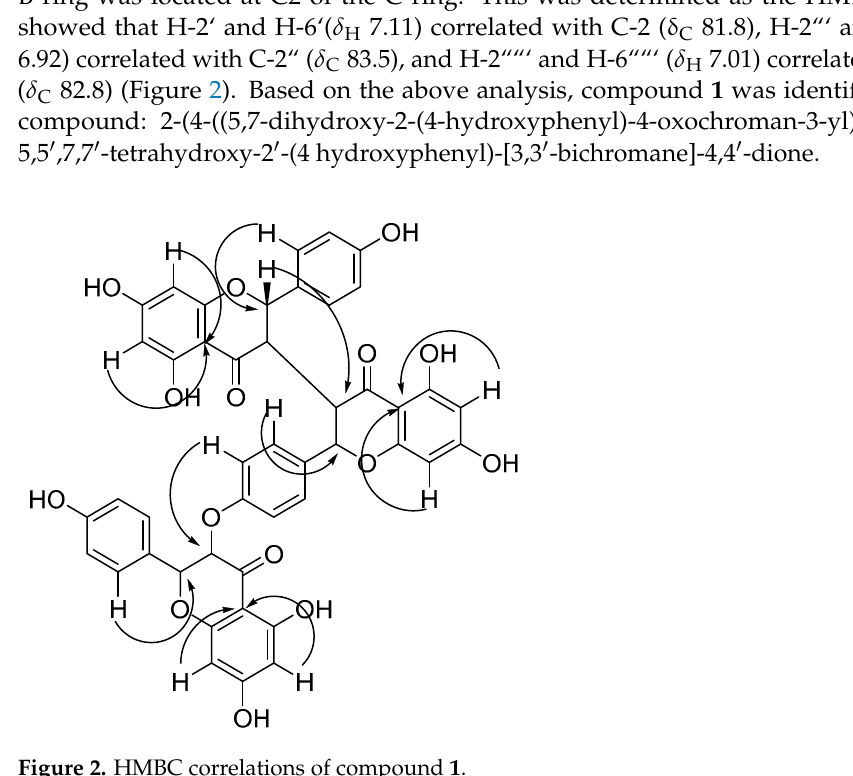
Table 2. In vitro cytotoxic effects (IC 50 , µ M) of compounds 1 – 6 , 8 and 9 on HepG2 and Vero cell